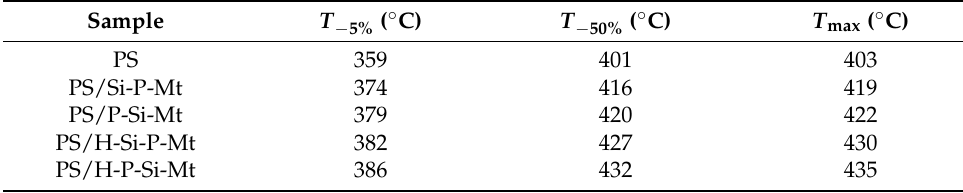
Table 4. TGA and DTG data of pure PS and PS/OMt